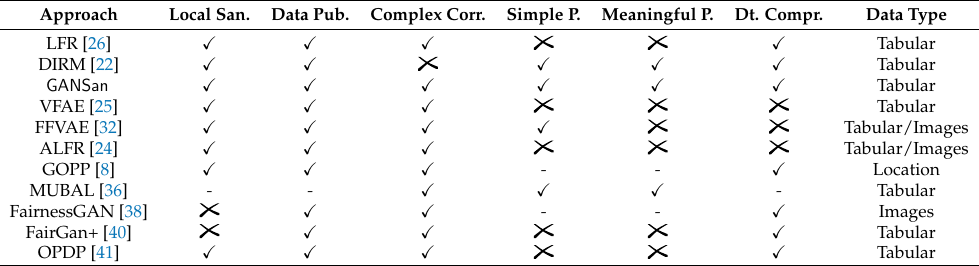
Table 1. Comparative table of preprocessing methods for fairness enhancement in which Data Pub. refers to the ability to published the transformed dataset while Local San. concerns the ability to transform a profile on-the-fly. In addition, Simple P. indicates the number of hyper-parameters (the lower the better), Meaningful P. refer to the ease of comprehension and usage of the hyper-parameters to achieve a chosen objective, Dt. Compr. refers to whether or not the input data space is preserved.